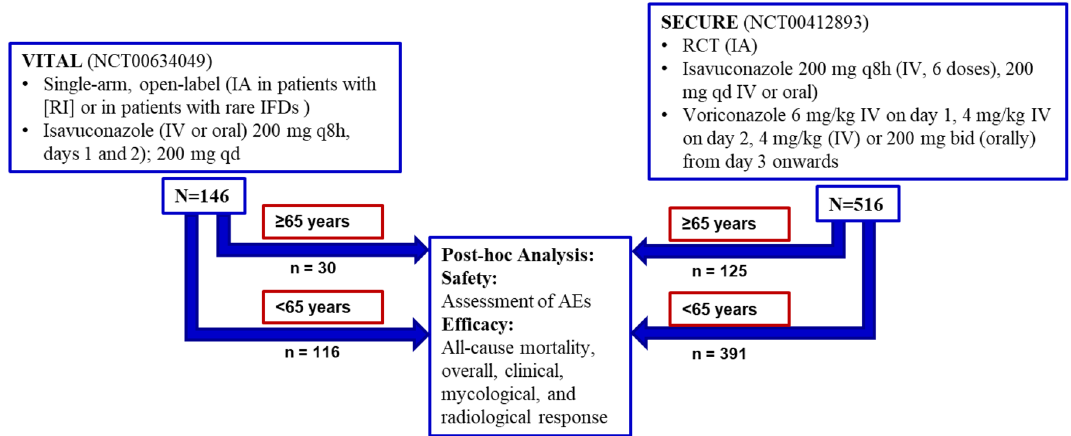
Figure 1. Description of the studies used in this post-hoc analysis and study design. AEs = adverse events, bid = twice a day, IFD = Invasive fungal disease; IA = invasive aspergillosis, IV = Intravenous, q8h = every 8 h, qd = once a day, RCT = randomized controlled trial, RI = Renal